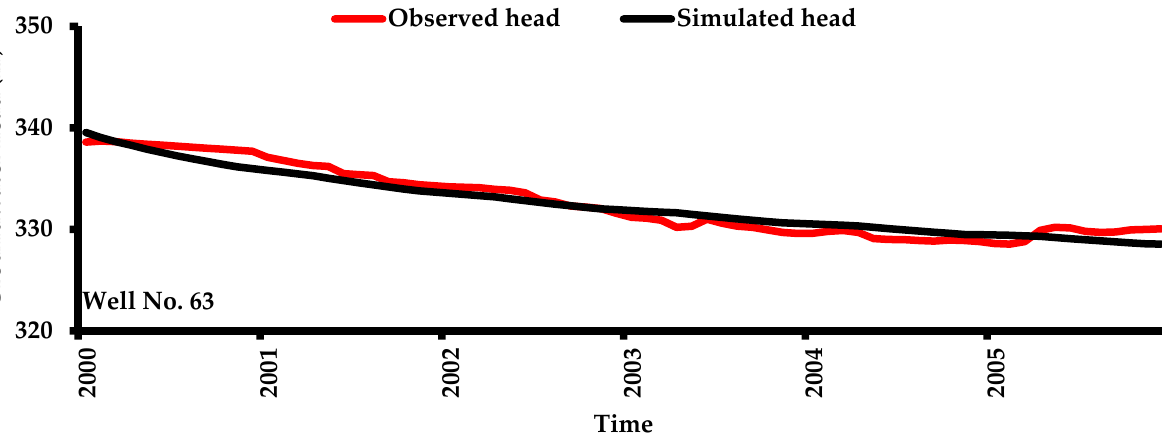
Figure 5. Transient calibration of groundwater head at well No. 63.